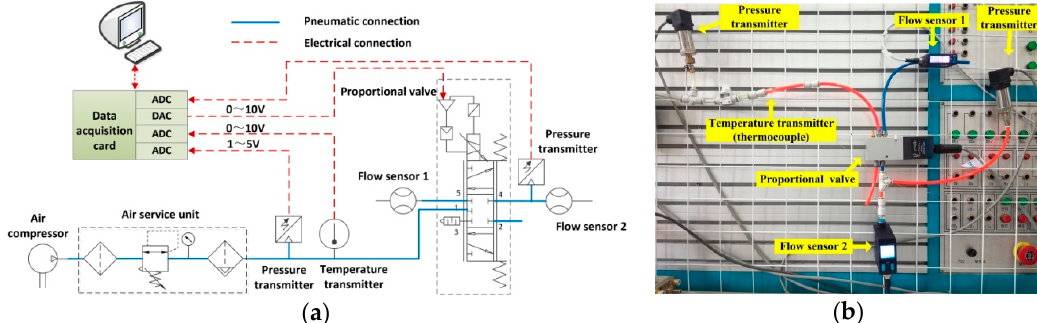
C : ( a ) Schematic diagram; ( b ) Test Figure 10. Pneumatic circuit for testing the flow coefficient C 1 : ( a ) Schematic diagram; ( b ) Test platform. Figure 10. Pneumatic circuit for testing the flow coefficient 1 platform. Table 3. Models and parameters of the measuring Table 3. Models and parameters of the measuring components.